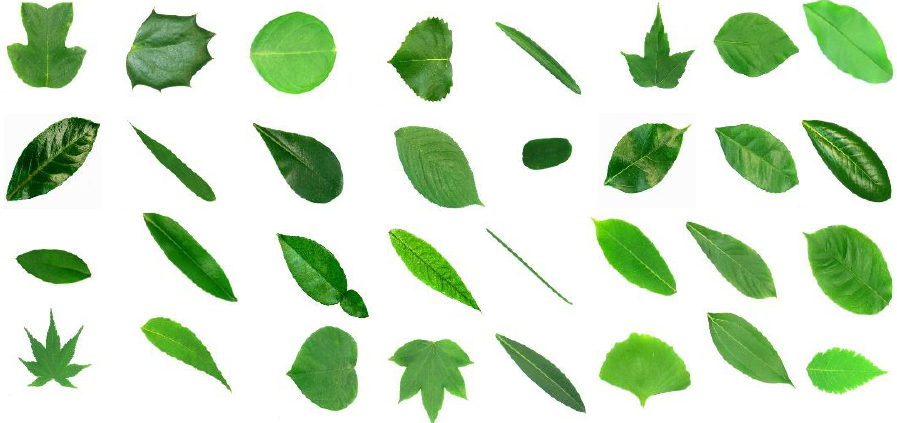
Figure 7. Standard leaf image of Flavia dataset.